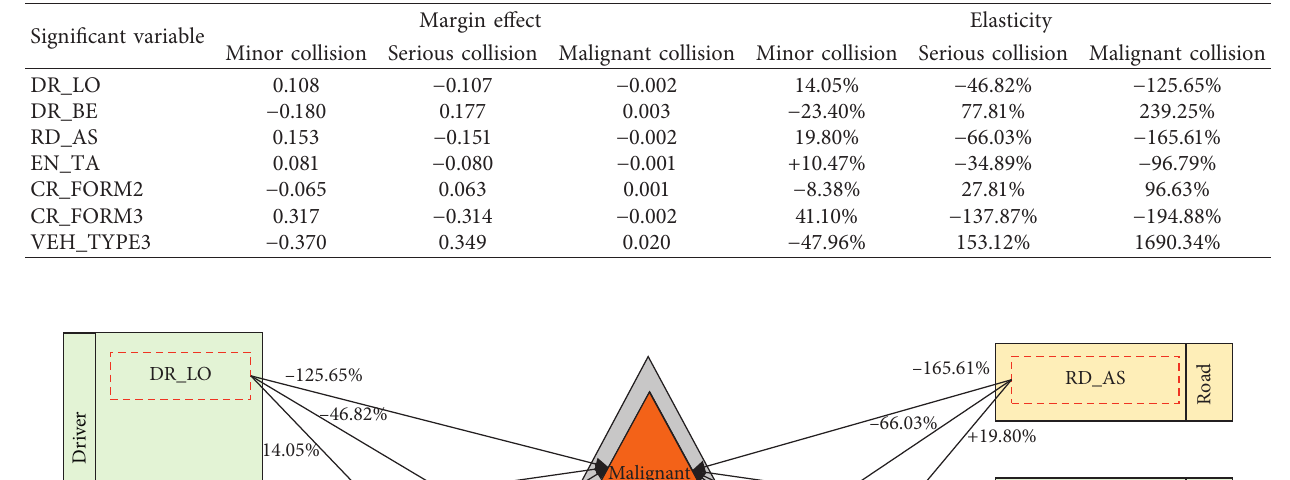
Figure 5: The distribution of coefficients. Table 7: Marginal effects and elasticities.